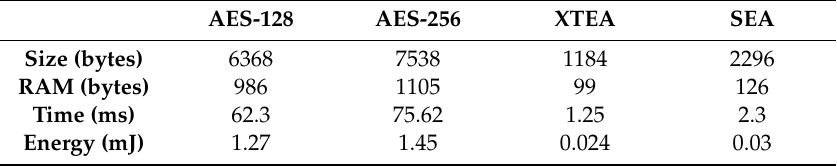
Table 5. Performance comparisons of encryption algorithms on 8-bit